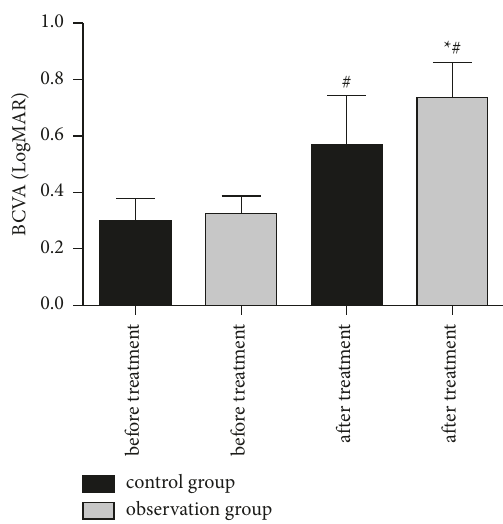
Figure 2: Visual acuity levels of two groups of patients at different times. Compared with the same group before treatment, # P < 0 . 05; compared with the control group, ∗ P < 0 . 05.